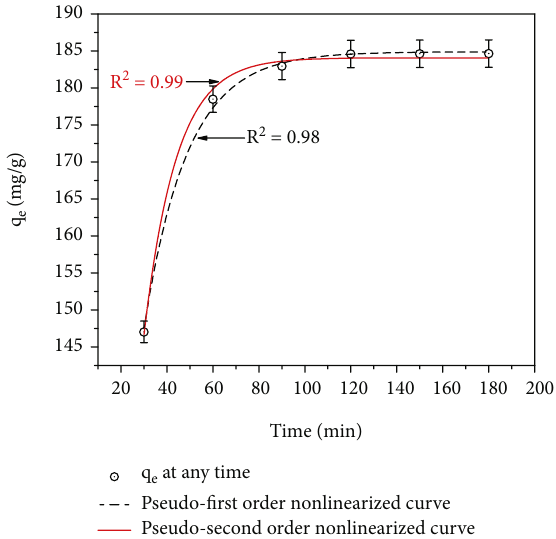
Figure 7: Adsorption kinetics of phosphorus by M-ARM in the form of PFO and PSO models.